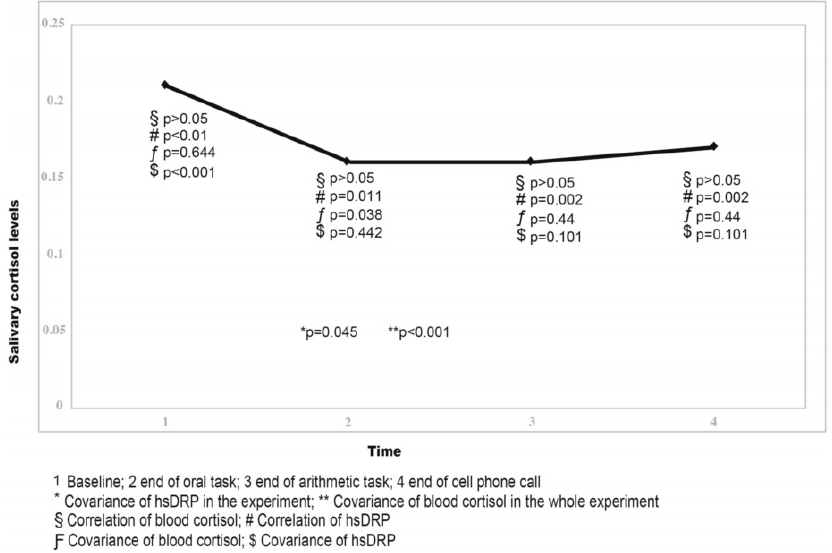
Figure 3. Salivary cortisol levels ( µ g/dL) during exposure and its covariance with baseline circulating hsCRP and cortisol. Table 4. Differences in slopes of the first time point sampling with the three following points